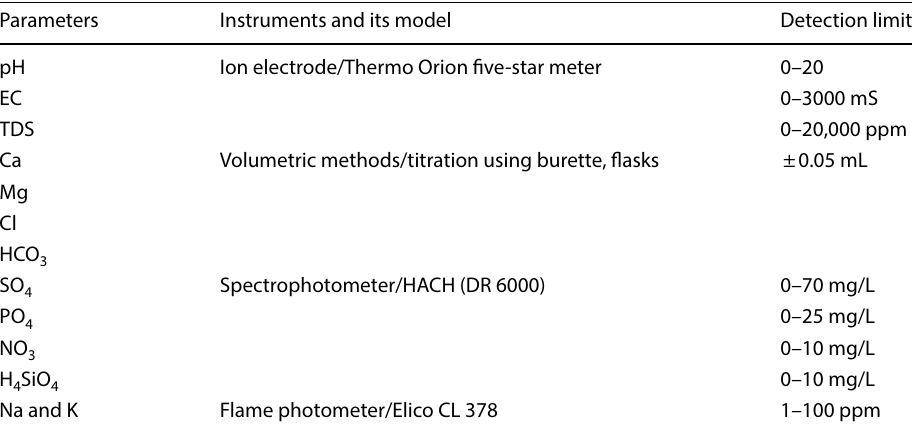
Table 2 Analytical instruments and its detection limits for the groundwater